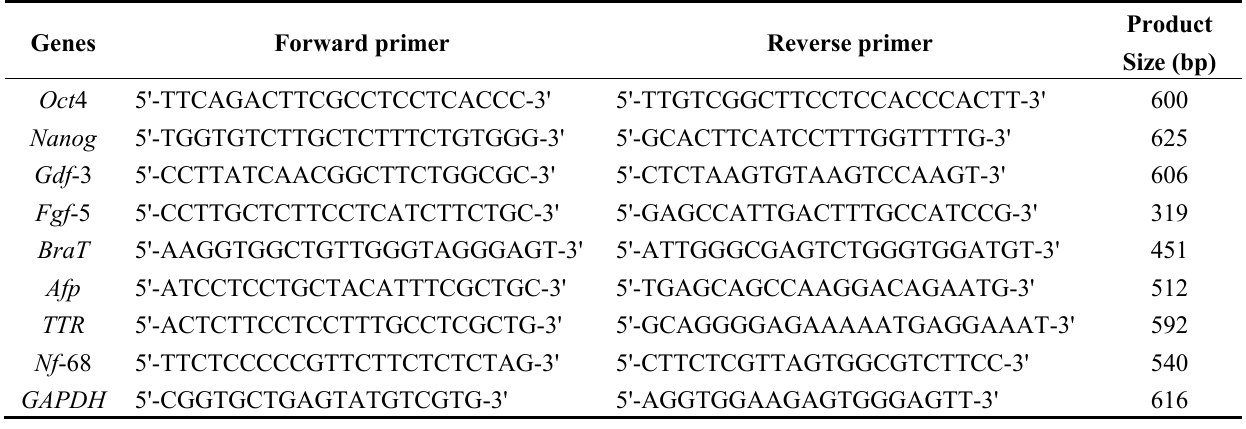
Table 7. The primers and size of the amplified